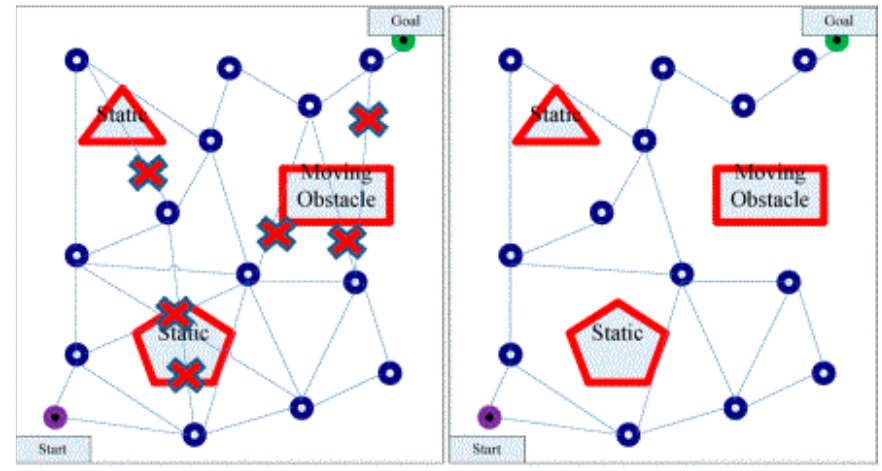
Figure 5. Illustration of PRM.